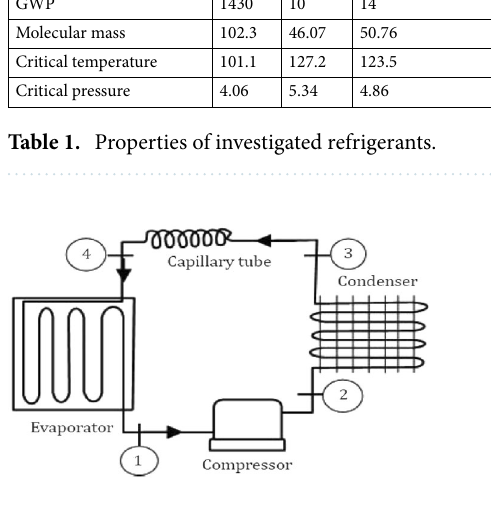
Figure 1. Block diagram of a refrigeration